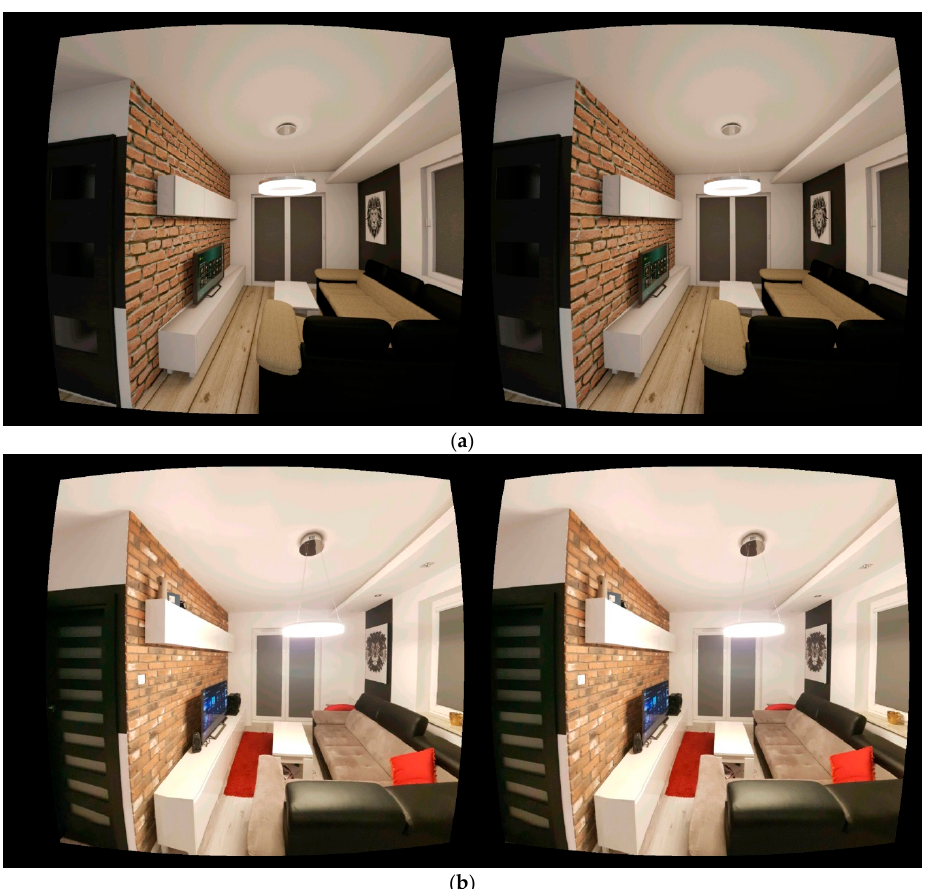
Figure 3. Rendering shot displayed in: ( a ) virtual reality glasses and ( b ) photo rendering room for left and right eye.